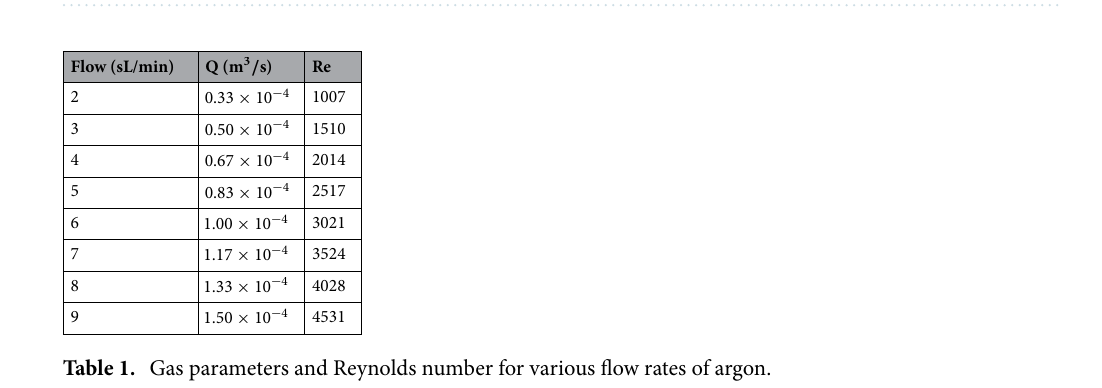
Figure 7. APPJ length, width, and 557.7 nm intensity variations with respect to the operating parameters. ( a ), ( d ), and ( g ) show the variation with respect to gas flow rate. ( b ), ( e ), and ( h ) show the variation with respect to electrode gap. ( c ), ( f ), and ( i ) show the variation with respect to applied voltage.